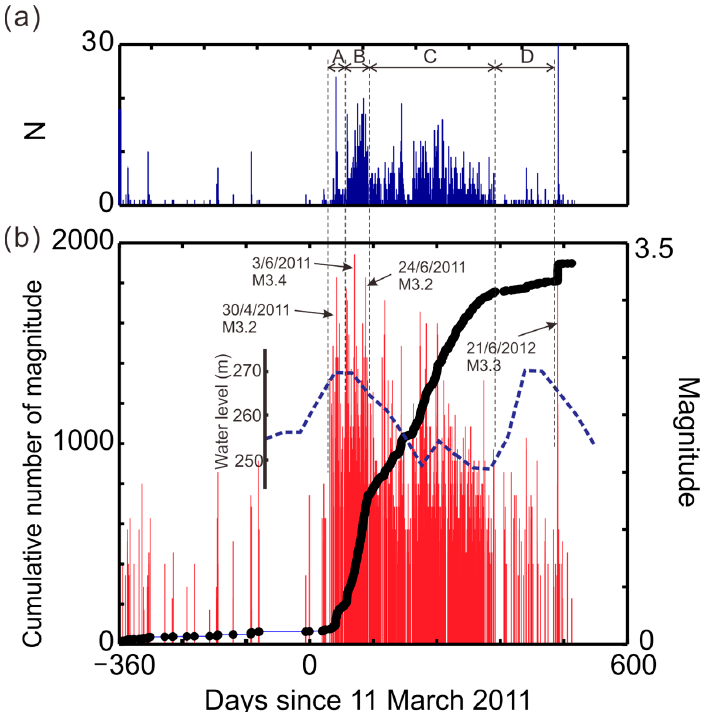
Figure 4. ( a ) Number of micro-earthquakes per day and ( b ) magnitudes and cumulative number of seismic events (N) during the 360 days before and 600 days after the Tohoku earthquake along with the water level of Lake Okura. The record ends on 1 August 2012.